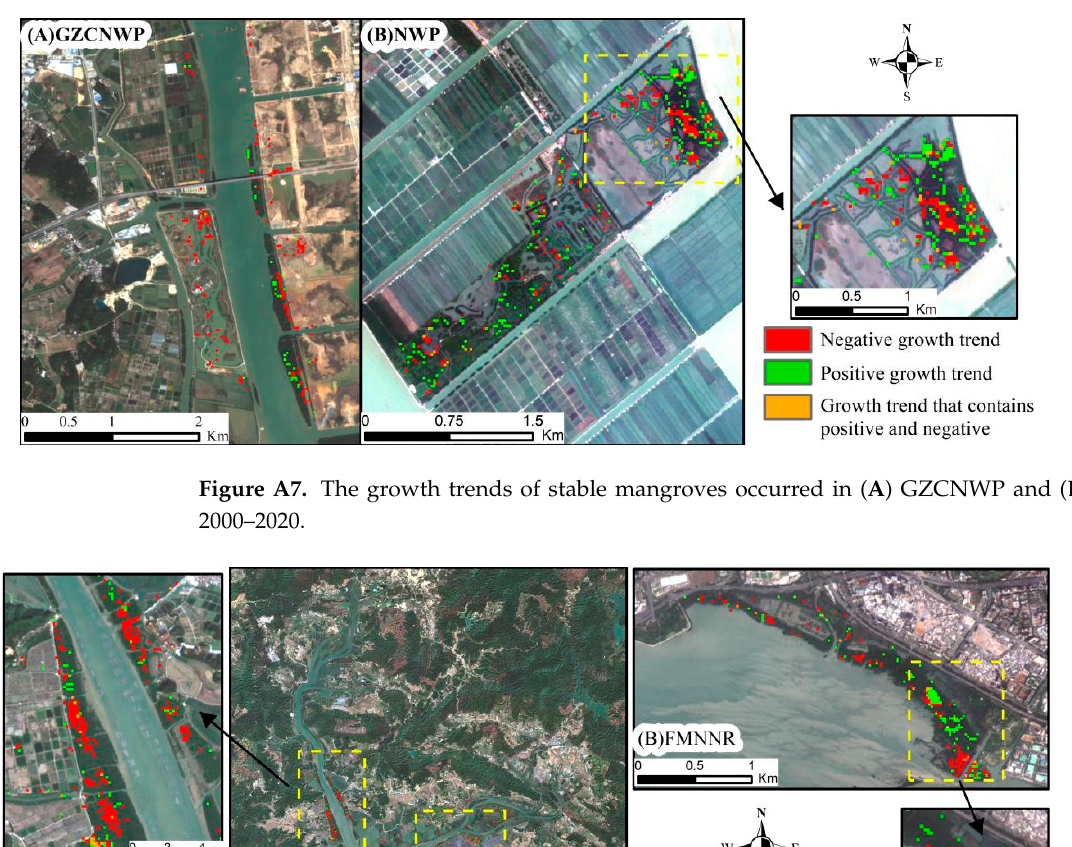
Figure A6. Mangrove gain and loss in FMNNR( A – D ) and GTZMNWP( E – H ) every five years from 2000 to 2020. ( A , E ): 2000–2005, ( B , F ): 2005–2010, ( C , G ): 2010–2015, ( D , H ): 2015–2020.